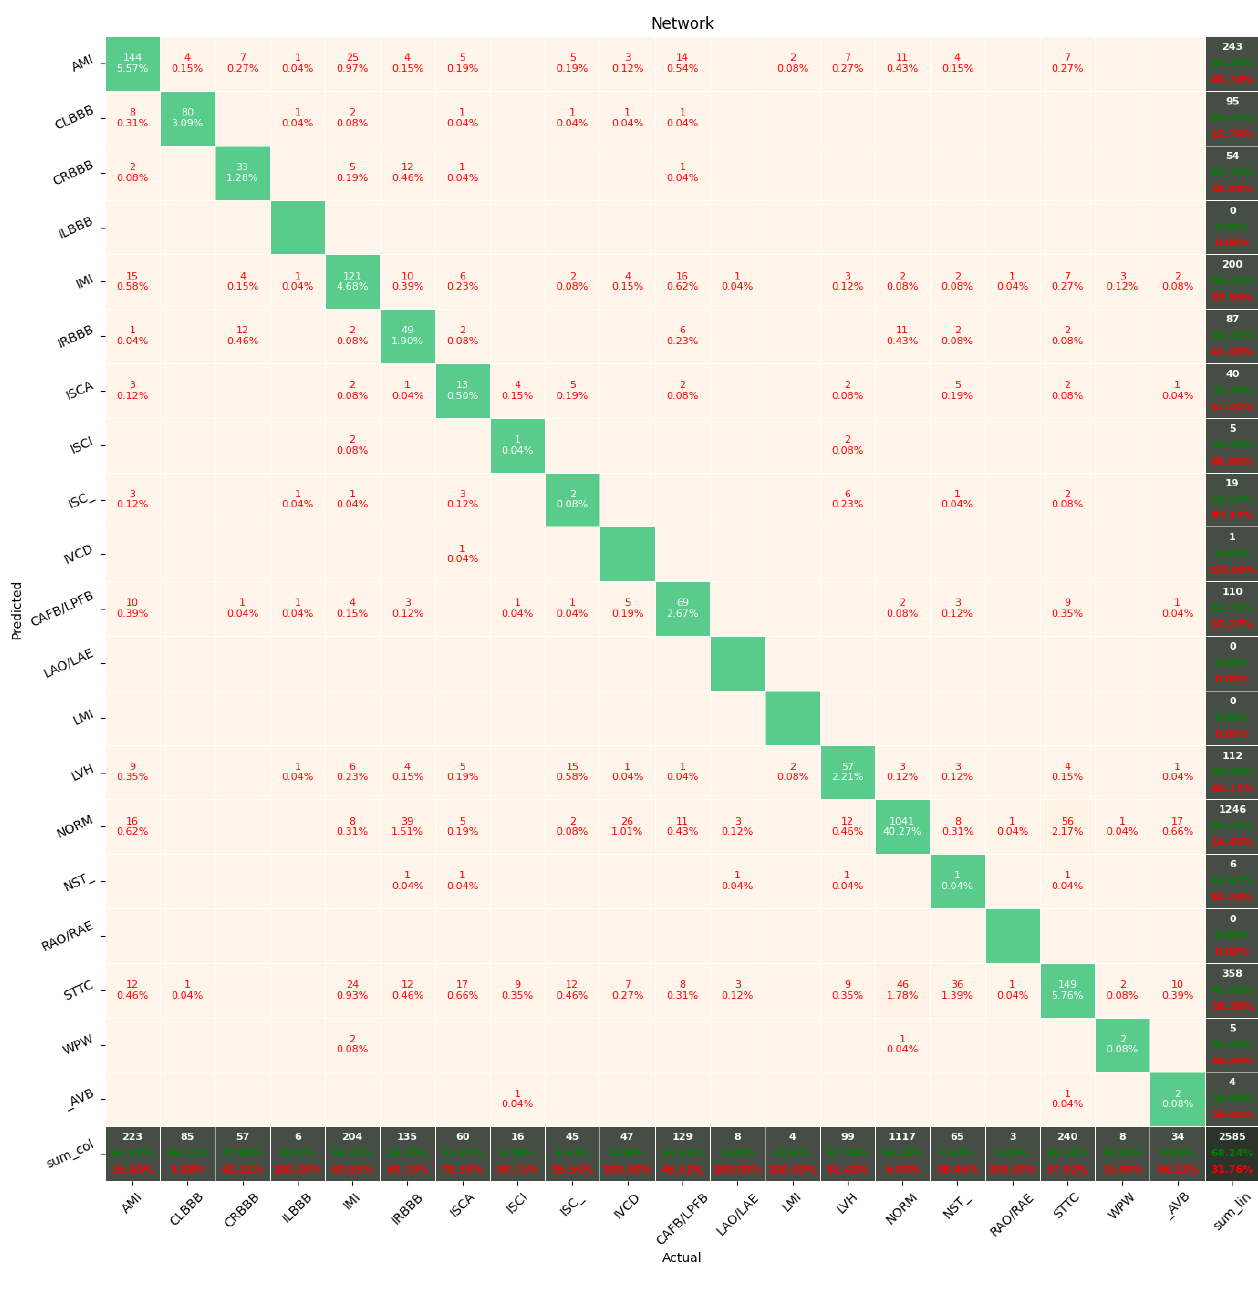
Figure 14. Confusion Matrix for softmax-based classification (20